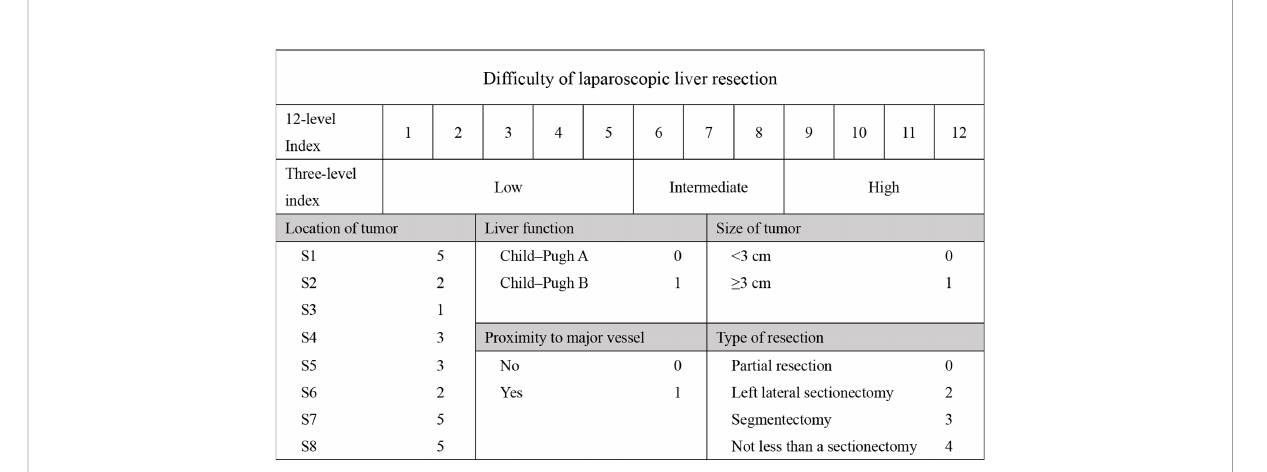
FIGURE 1 Indexes of dif fi culty of laparoscopic liver resection based on